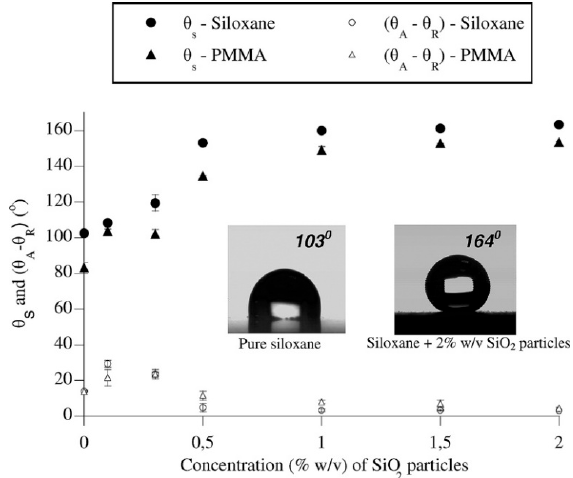
Figure 6. Static contact angle ( θ s) and contact angle hysteresis ( θ A −θ R ) vs. the concentration of SiO 2 particles. Photographs that show measurements of θ s on pure siloxane (Rhodorsil) and siloxane with 2% w / v SiO 2 particles are included. Reprinted with permission from [87], Copyright (2008) American Chemical Society.